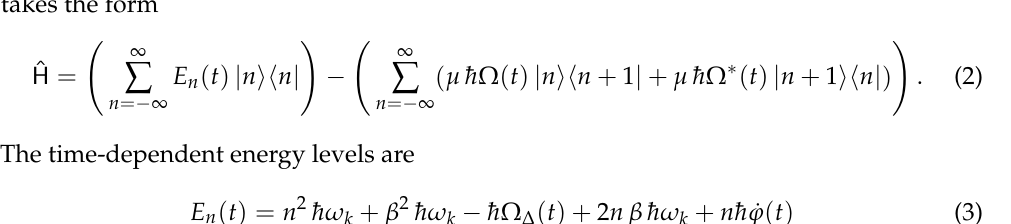
2¯ hk , with transitions ·